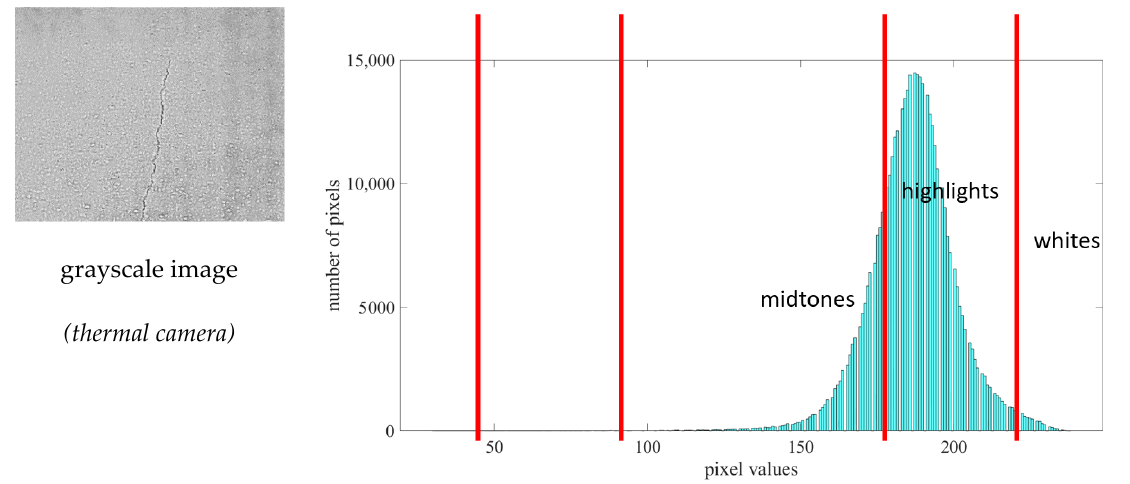
Figure 15. Histogram tonal zone representation of the sample image using an ordinary camera.